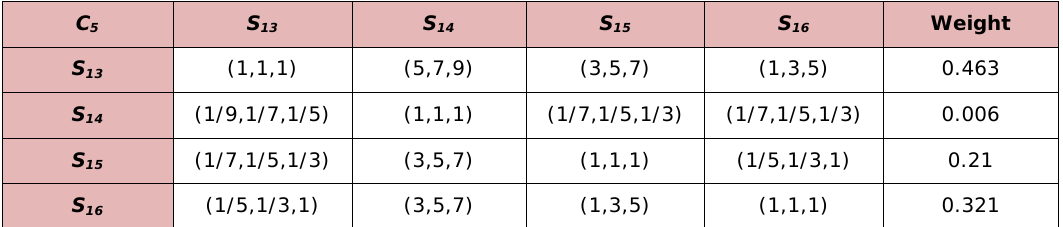
Table 7. “Fuzzy comparison matrix of the sub-criteria with respect to support”.